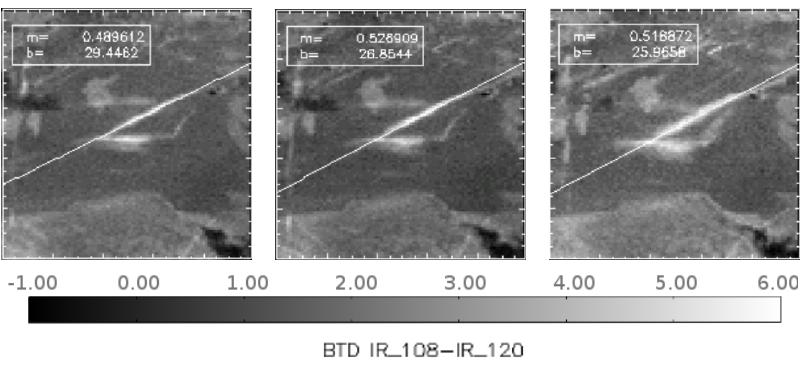
Fig. 8. Output of Step I: Contrail with its corresponding line at different stages of its development. On each plot, the line y = mx + b equation parameters. Left: at time t . Centre: at time t +25min. Right: at time t +55min. Background: BTD image 10.8µm–12.0µm, in K.